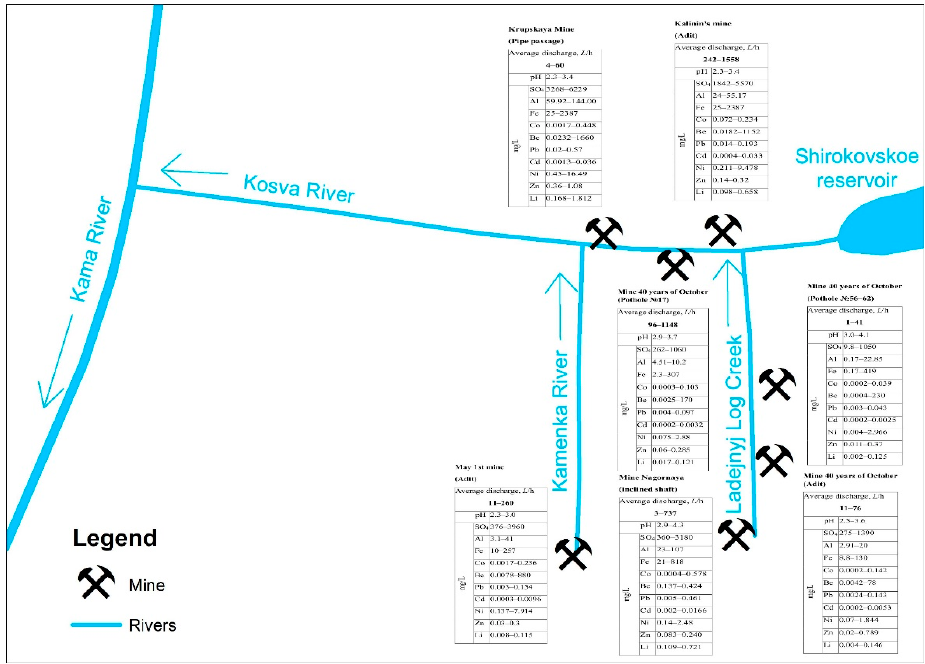
Figure 3. Location scheme and characteristics of AMD discharge in the Kosva River basin for the period from 2013 to 2019 [20].